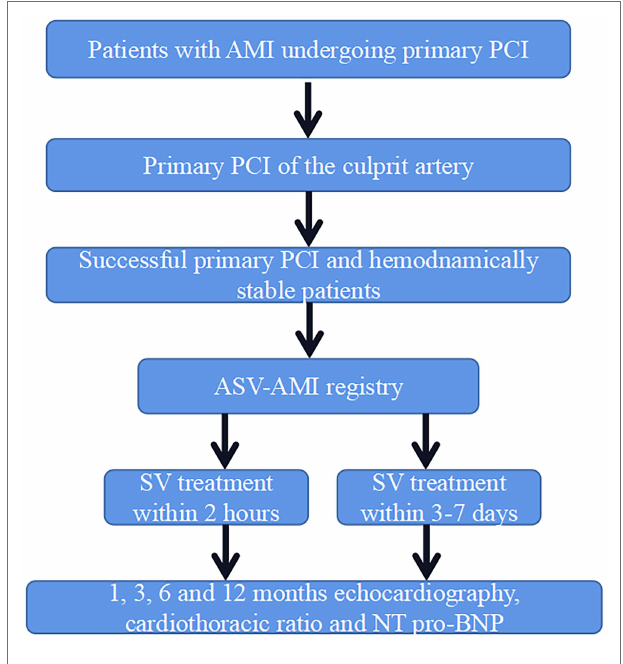
FIGURE 1 | Study design.